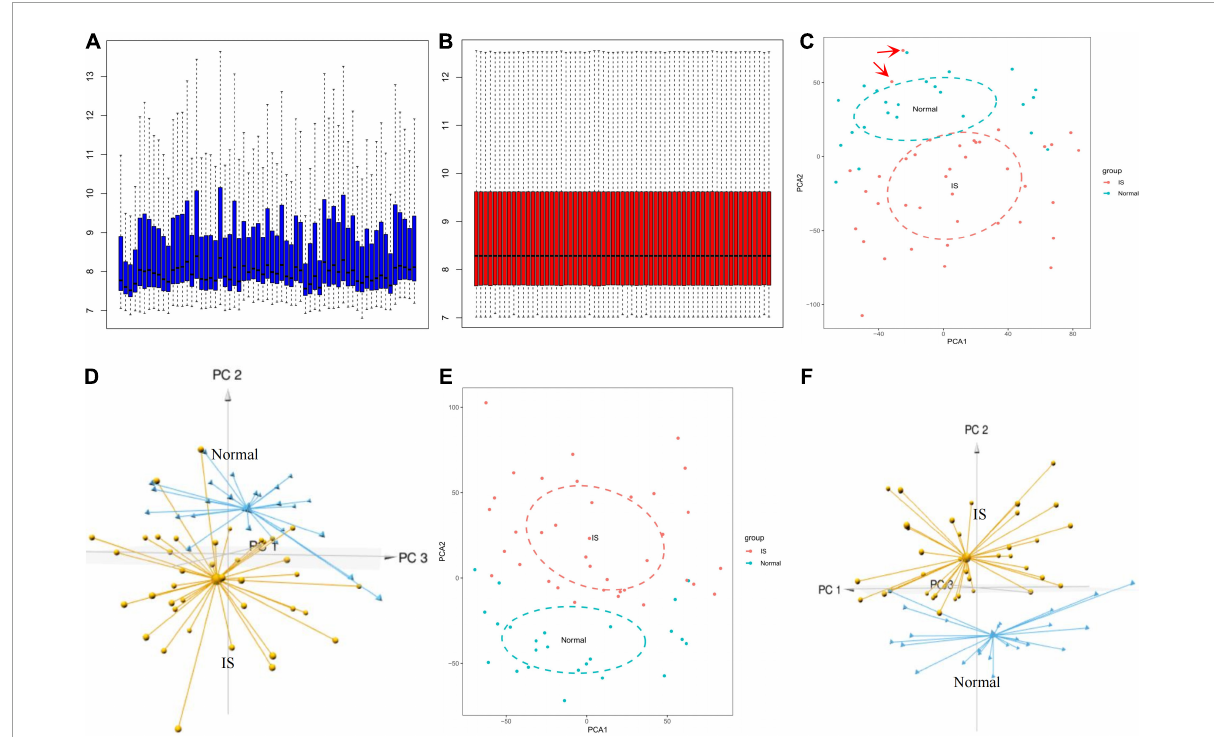
FIGURE2 GSE16561 data set preprocessing. Box plot showing the gene expression level between different samples before (A) and after (B) normalization. 2D and 3D PCA plots demonstrated the distribution of samples before (C,D) and after (E,F) pretreatment. PCA, principal components analysis.